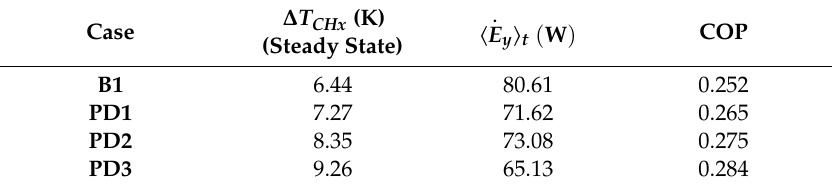
Table 7. Performance results for di ff erent length combinations of stack.